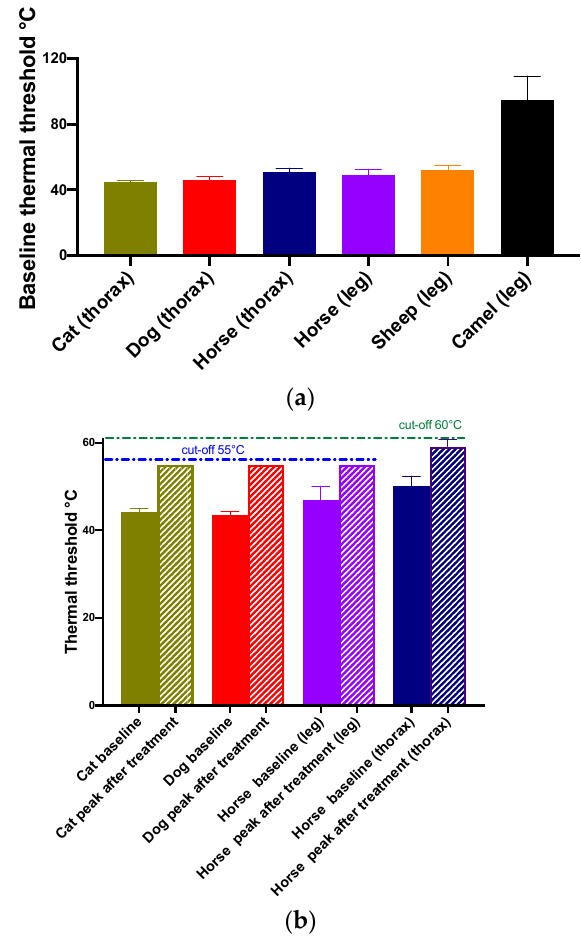
Figure 9. ( a ) Mean ± SD baseline (no treatment) thermal nociceptive thresholds (TTs) (°C) measured on the thorax in cats ( n = 16), dogs ( n = 8) and horses ( n = 21) and on a leg in horses ( n = 15), sheep ( n = 11) and camels ( n = 3). ( b ) Mean ± SD pre treatment and peak post analgesic treatment (see text for detail) TTs (°C) measured on the thorax in cats ( n = 6), dogs ( n = 2) and horses ( n = 8) and on a forelimb in horses ( n = 10). Thermal threshold reached cut-out (55° or 60 °C as shown) in all cats, dogs and in horses using the leg site. For the horse thoracic site, those reaching cut-out ( n = 4) were deemed a TT of 60 °C for illustrative purposes.